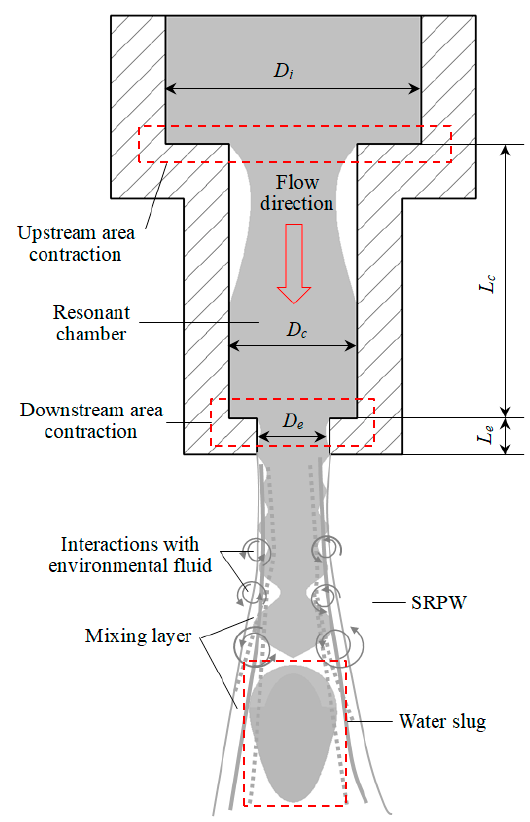
Figure 1. Schematic diagram of an organ-pipe nozzle and the generation of a self-resonating waterjet (SRWJ).